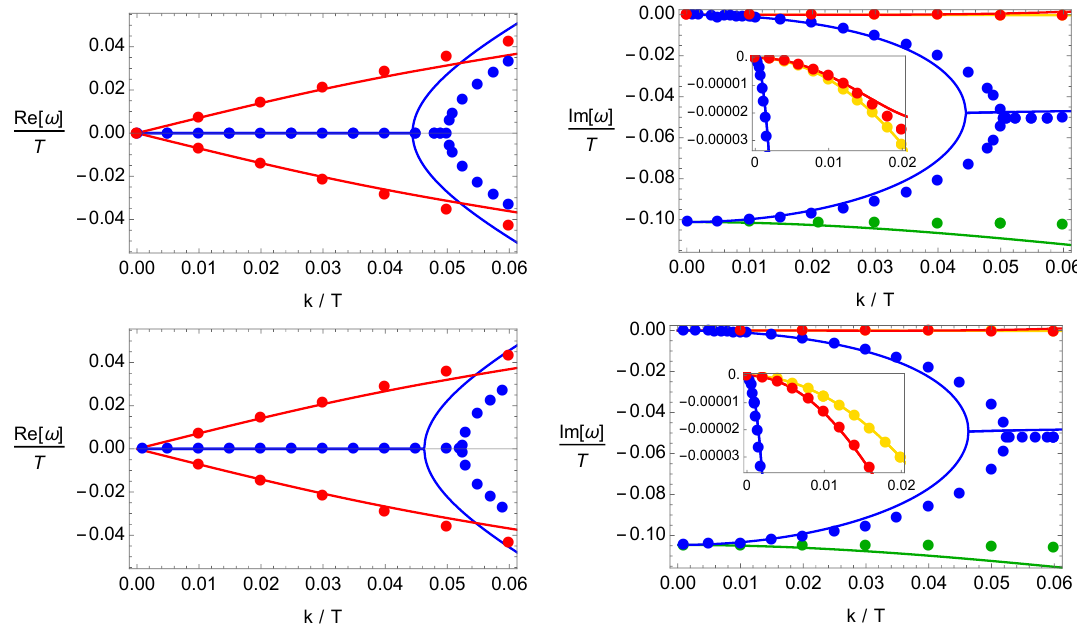
Figure 2 . Dispersion relations of the lowest QNMs at zero density ( µ/T = 0 ) and B/T 2 6 = 0 . Top and bottom panels are respectively for B/T 2 = 0 . 5 , 1